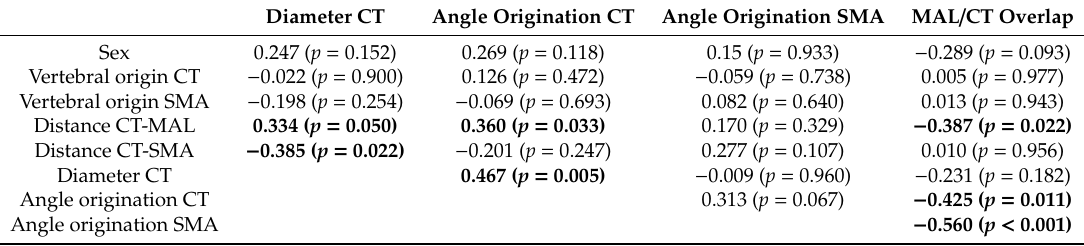
Table 2. Results of partial correlation analyses controlling for age among variables. Significant values are indicated in bold. It is interesting to note that the vertebral origin of the CT and SMA did not yield significant